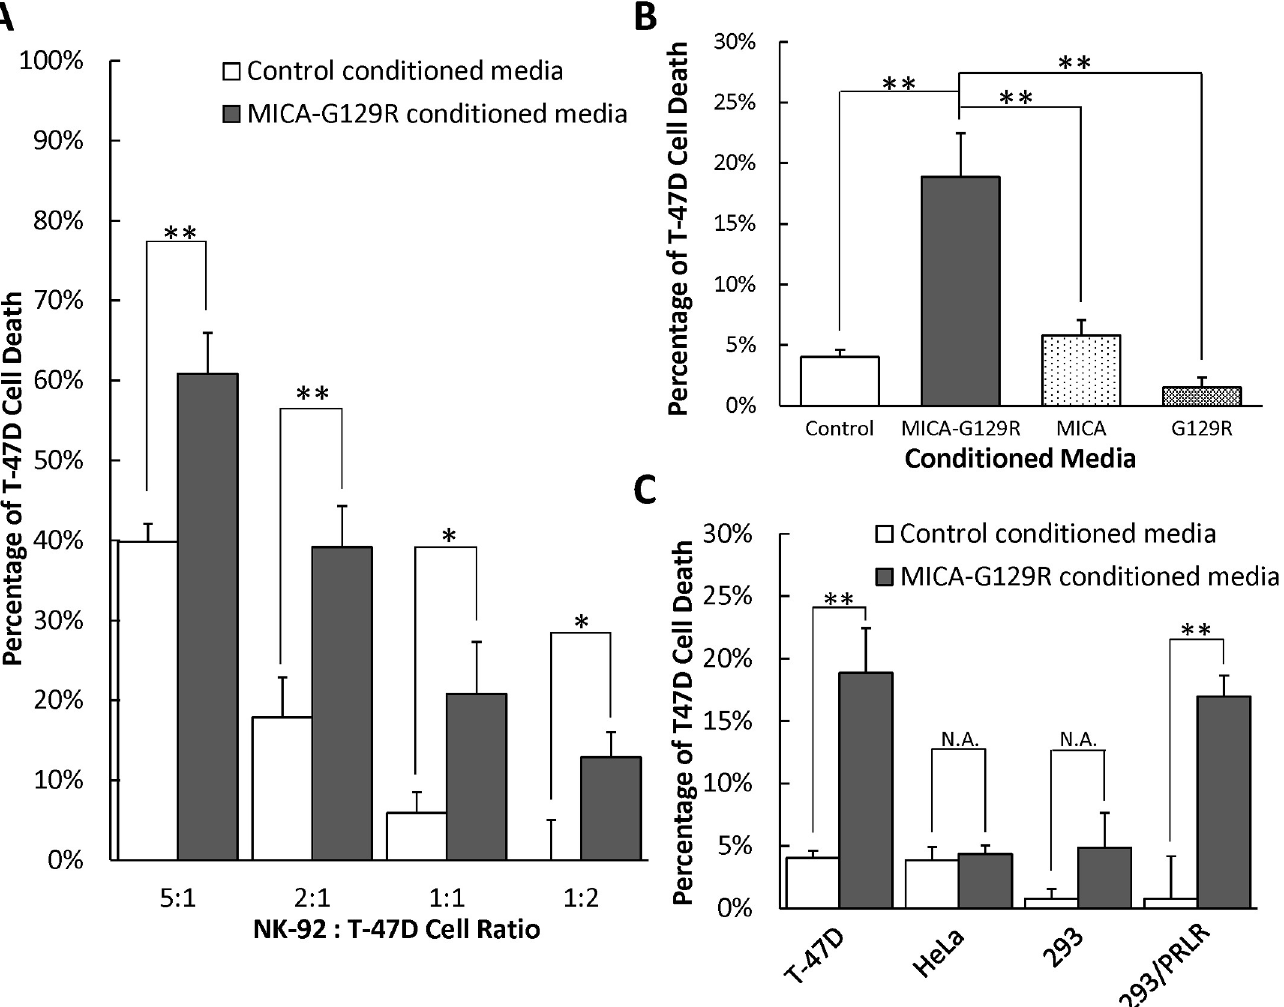
Fig 3. MICA-G129R fusion protein enhances the cytotoxicity of NK-92 cells on PRLR-positive T-47D cells. The cytotoxicity of NK-92 cells on T-47D cells was measured at different conditions. A. T-47D cells were co-cultured with NK-92 cells at different effector/target ratios 5:1, 2:1, 1:1, and 1:2 for 24 hours with control or MICA-G129R conditioned media. B. The co-culture of T-47D cells and NK-92 cells at the ratio of 1:1 was treated with the control, MICA-G129R, MICA or G129R conditioned media for 24 hours. C. The NK-92 cells were co-cultured with T-47D cells, HeLa cells (PRLR-negative), 293 (PRLR-negative) or PRLR ectopic expressed 293 cells at the ratio of 1:1 with control or MICA-G129R conditioned media for 24 hours. Data are presented as mean ± SD (n = 3). � indicates P < 0.05; �� indicates P <